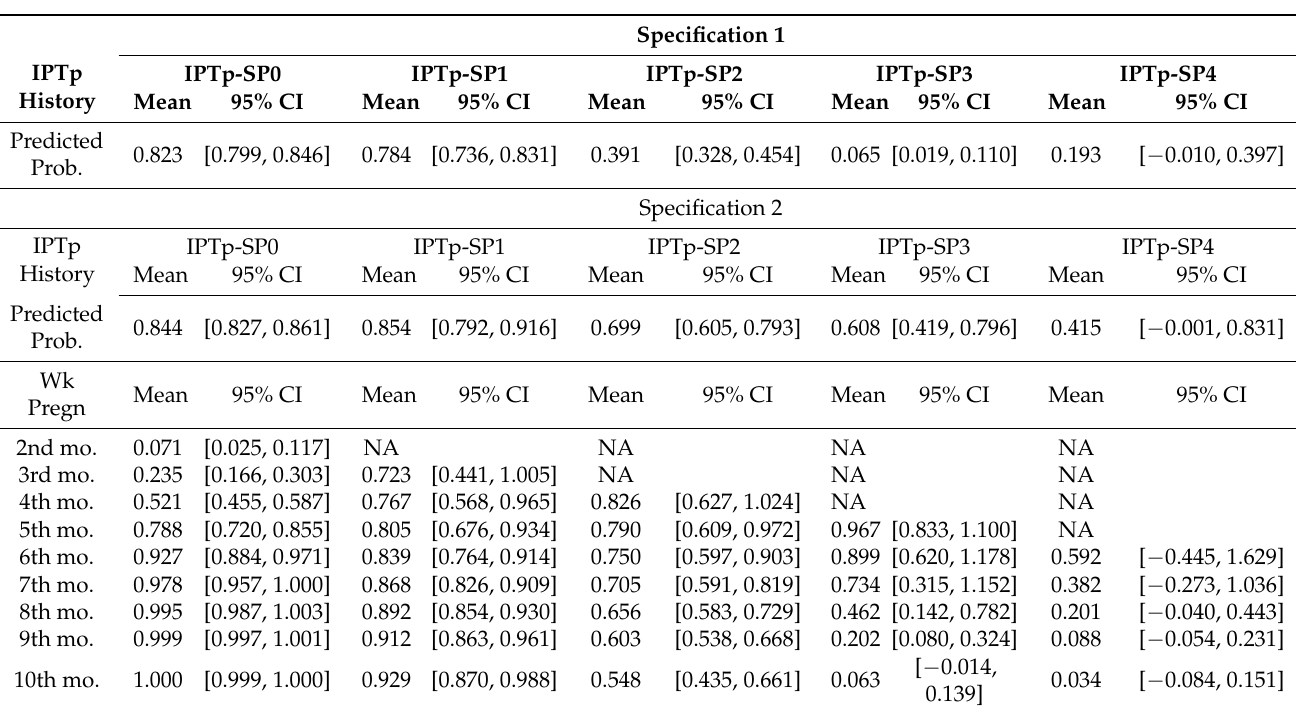
Table 2. Predicted Probability of Receiving IPTp Prescription at Current ANC Visit, Main Results from Logit